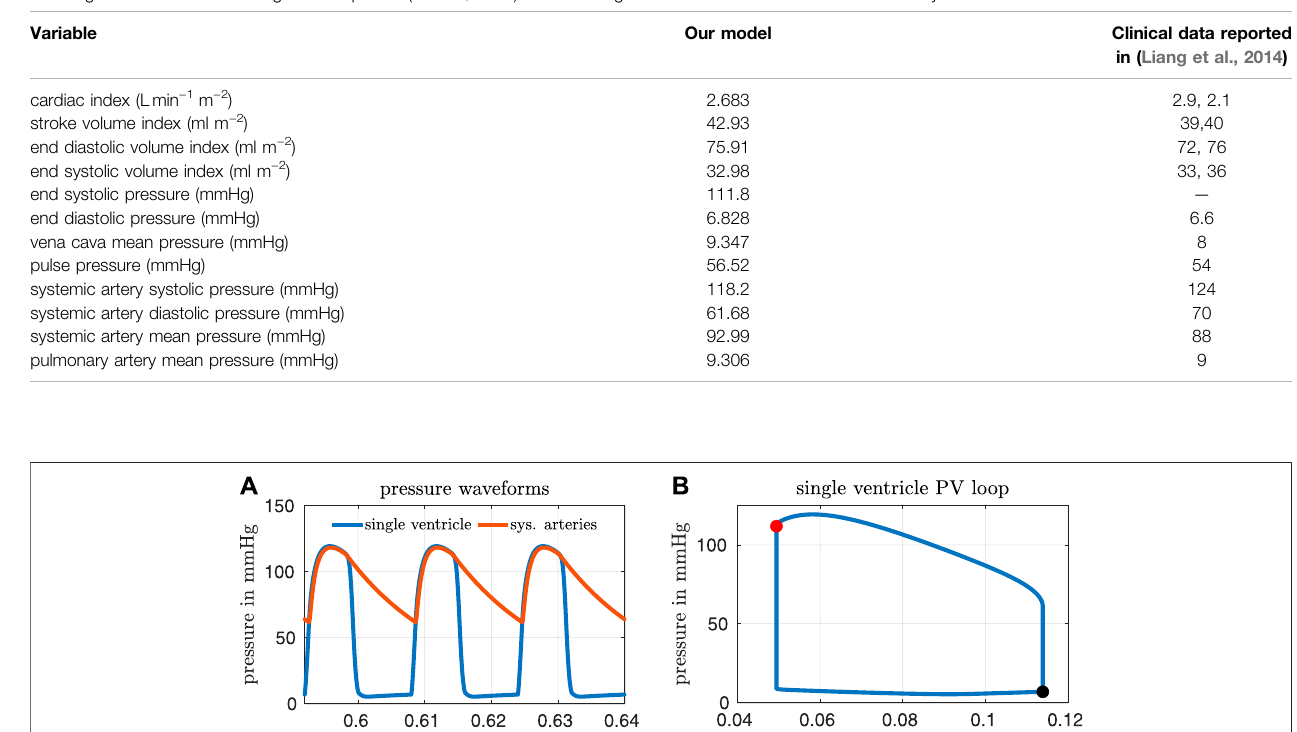
TABLE 3| Hemodynamicvariablescalculatedfromourcalibrated model withaclosed fenestration,compared totheclinicaldatareportedbyLianget al.(Lianget al.,2014). Based on a report by Ohuchi, our model ’ s vena cava mean pressure, cardiac index, end diastolic volume index, and ejection fraction are all within the range of a “ late- surviving ” and “ excellent-surviving ” Fontan patient (Ohuchi, 2017). The indexing in the fi rst four variables assumes a body surface area of 1.5 m 2 .